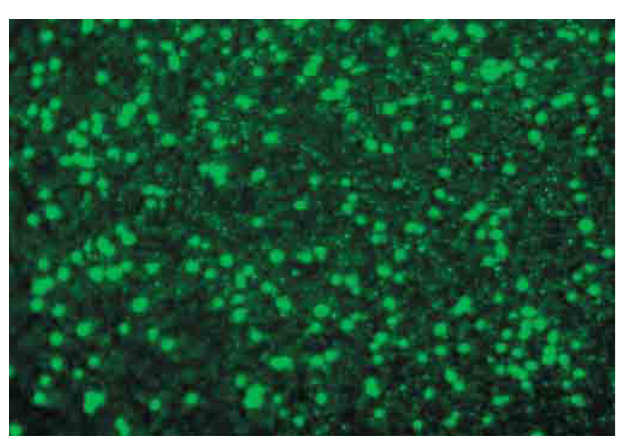
Figure 1. An Image from an Epifl uorescence Microscope of Seawater Stained with the Dye SYBR Green to Reveal the Bacterial Cells and Smaller Viral Particles (Image: Jed